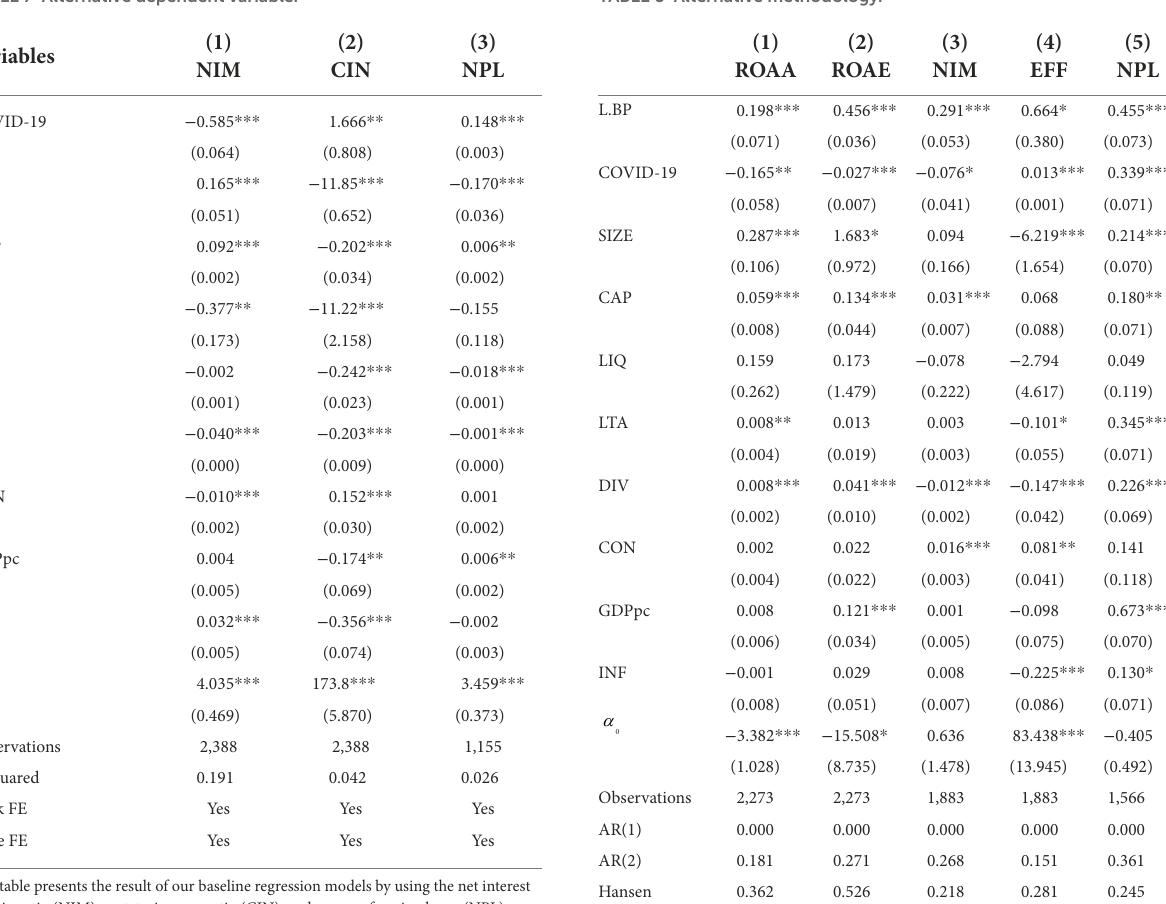
TABLE 7 Alternative dependent variable. TABLE 8 Alternative methodology.